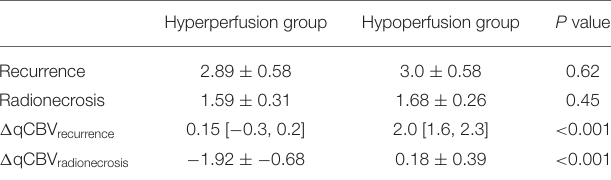
TABLE 3 | The detailed results of comparisons between two